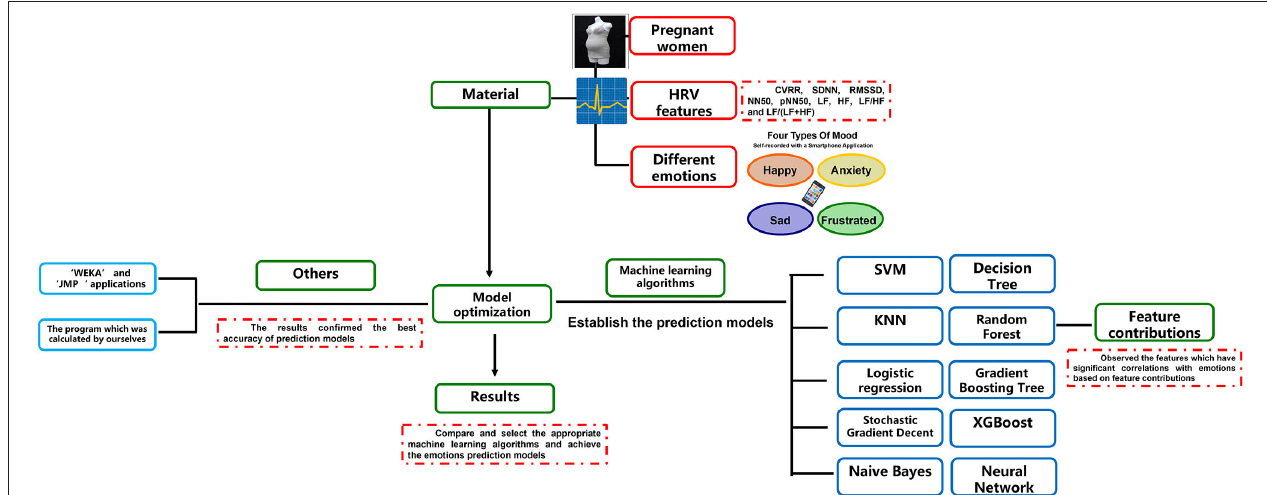
FIGURE 1 | The design of this study. The design of this study was plotted. CVRR, coefficient of variation R-R interval; SDNN, standard deviation of all NN intervals; RMSSD, square root of the mean squared differences of successive NN intervals; NN50, number of interval differences of successive RR-intervals > 50ms; pNN50, the proportion derived by dividing NN50 by the total number of RR-intervals; LF, frequency domain features include low frequency; HF, high frequency; LF/HF, the ratio of low frequency to high frequency; SVM, support vector machine; k-NN, k-nearest neighbor; SGD, stochastic gradient descent; LR, logistic regression; DT, decision tree; NB, naïve Bayes; RF, random forest; GBT, gradient boosting trees; XGBoost, extreme gradient boosting; ANN, artificial neural